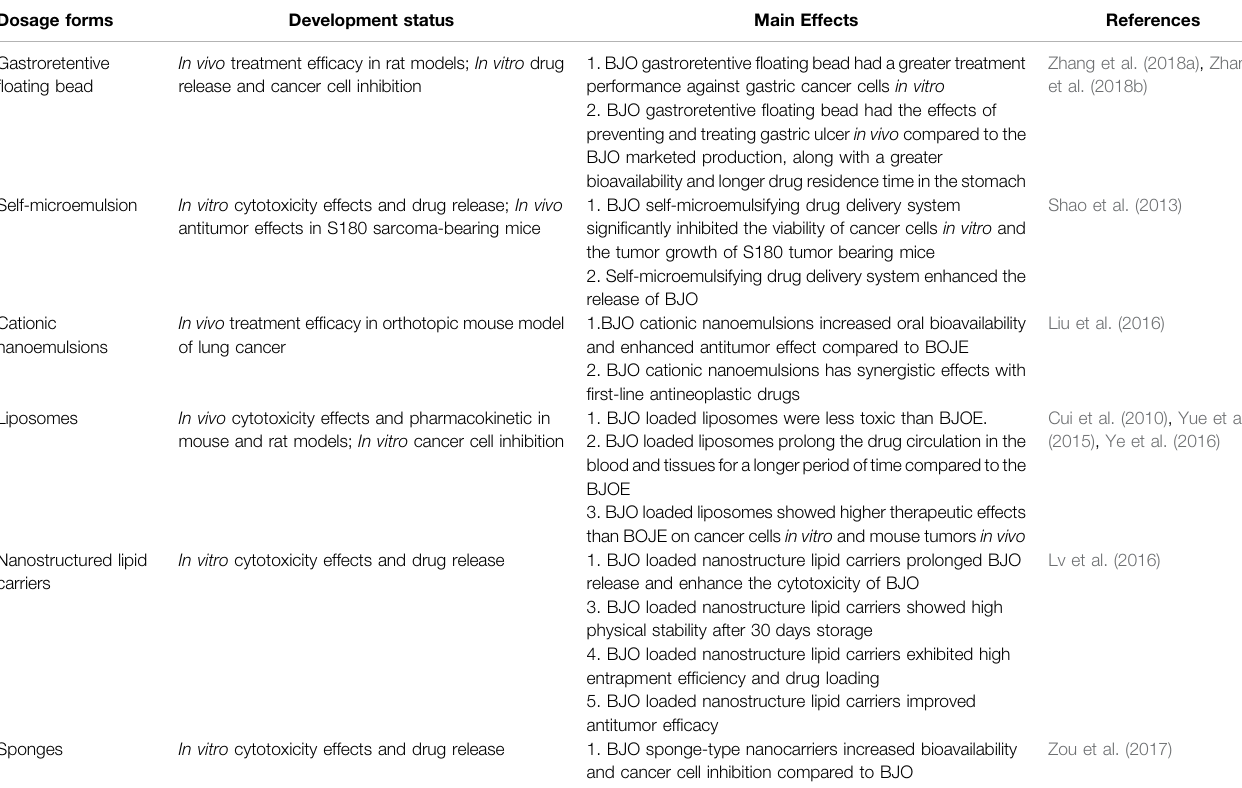
TABLE 3 | Status of new dosage forms of